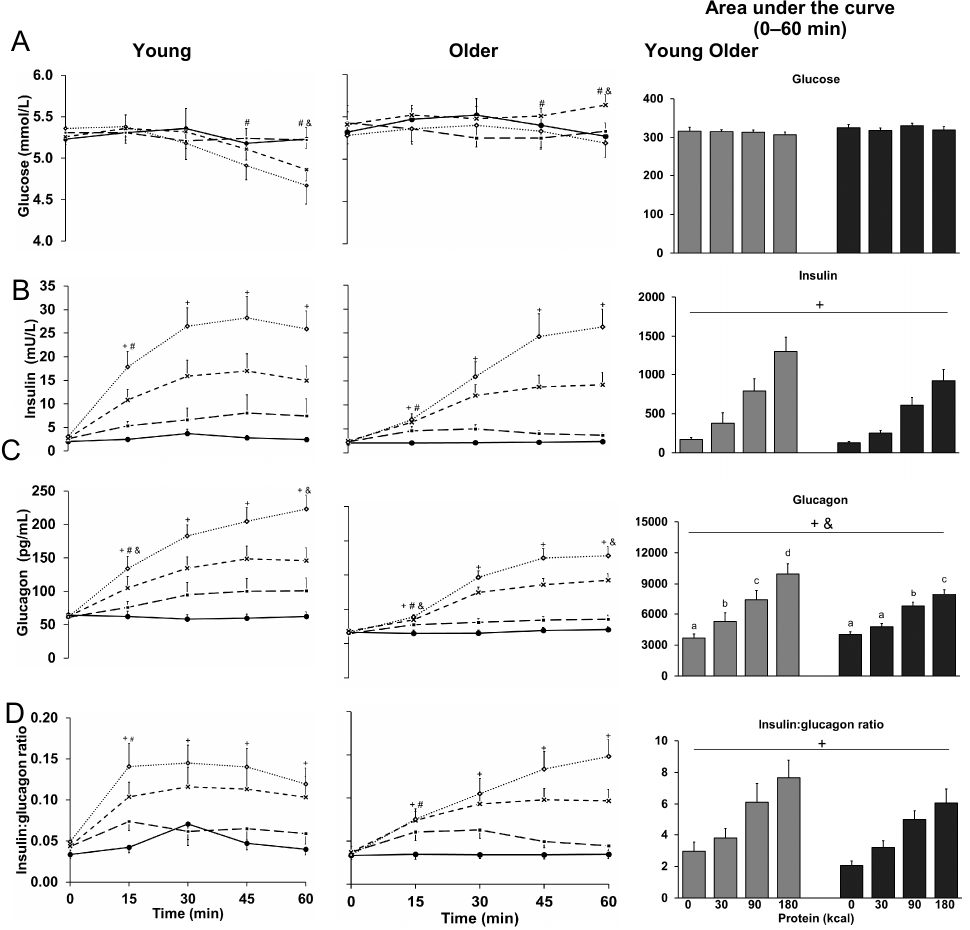
Figure 2. Mean (±SEM) and area under the curve concentrations of blood glucose ( A ); plasma insulin ( B ); glucagon ( C ); and ratio of insulin to glucagon ( D ) in healthy younger ( n = 10) and older ( n = 10) men during intraduodenal infusions of saline (control; solid line with closed circles) and whey-protein loads of 30 kcal (7.5 g protein; dashed line with closed squares), 90 kcal (22.5 g protein; dashed line with crosses) and 180 kcal (45 g protein; dotted line with open diamonds). Effects of protein-load, age, and the interaction-effect of protein-load by age were determined using a mixed-effect model with baseline concentrations as a covariate and post-hoc Bonferroni correction. Statistical significance was accepted at p < 0.05. + p < 0.05 Effect of protein-load. Post-hoc tests: higher glucagon (AUC 0–60 min and 60 min) during 30 kcal protein infusion compared to control (AUC: p = 0.004, 60 min: p = 0.029); higher insulin, glucagon, and ratio of insulin to glucagon during 90 kcal and 180 kcal protein infusions compared to control (insulin: AUC: both p < 0.001, 60 min: both p < 0.001; glucagon: AUC: both p < 0.001, 60 min: both p < 0.001; ratio of insulin to glucagon: AUC: p < 0.001 and p = 0.002, 60 min: p = 0.001 and p < 0.001). # p < 0.05 Effect of age. & p < 0.05 Interaction-effect of protein-load by age. a , b , c , d p < 0.05 Interaction-effect post-hoc tests: a different letter indicates a